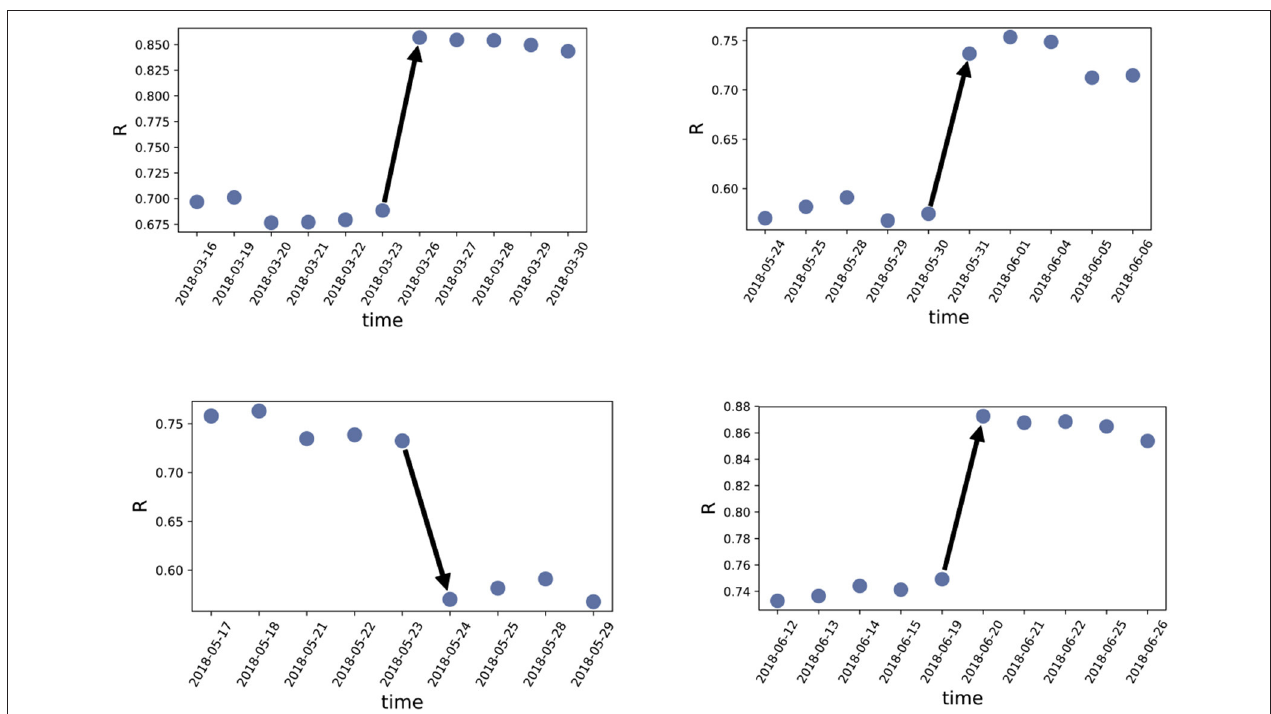
FIGURE 8 | Impact of the trade policy.